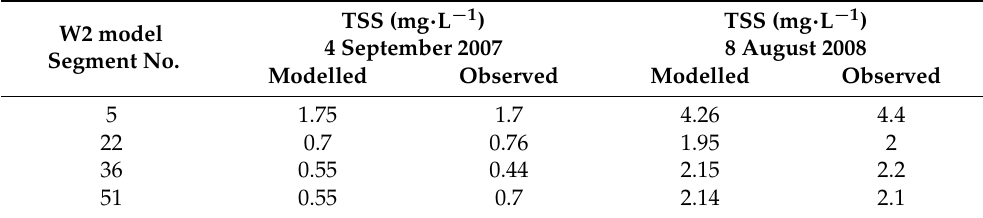
Table 5. Comparison of modeled and observed TSS values.